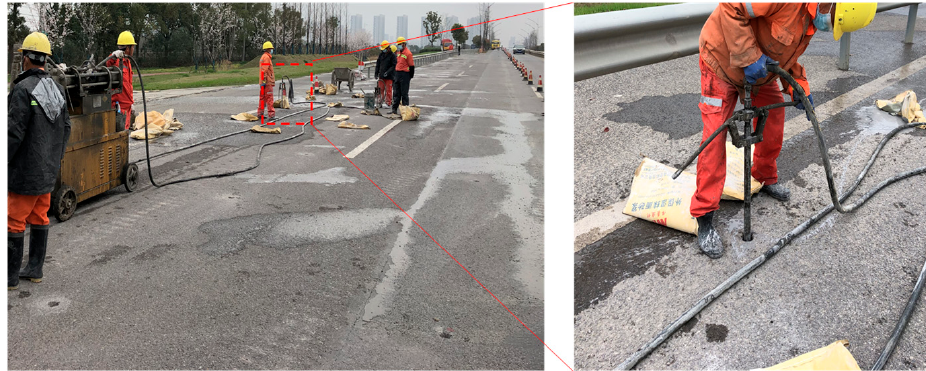
Figure 10. Cement grouting process.